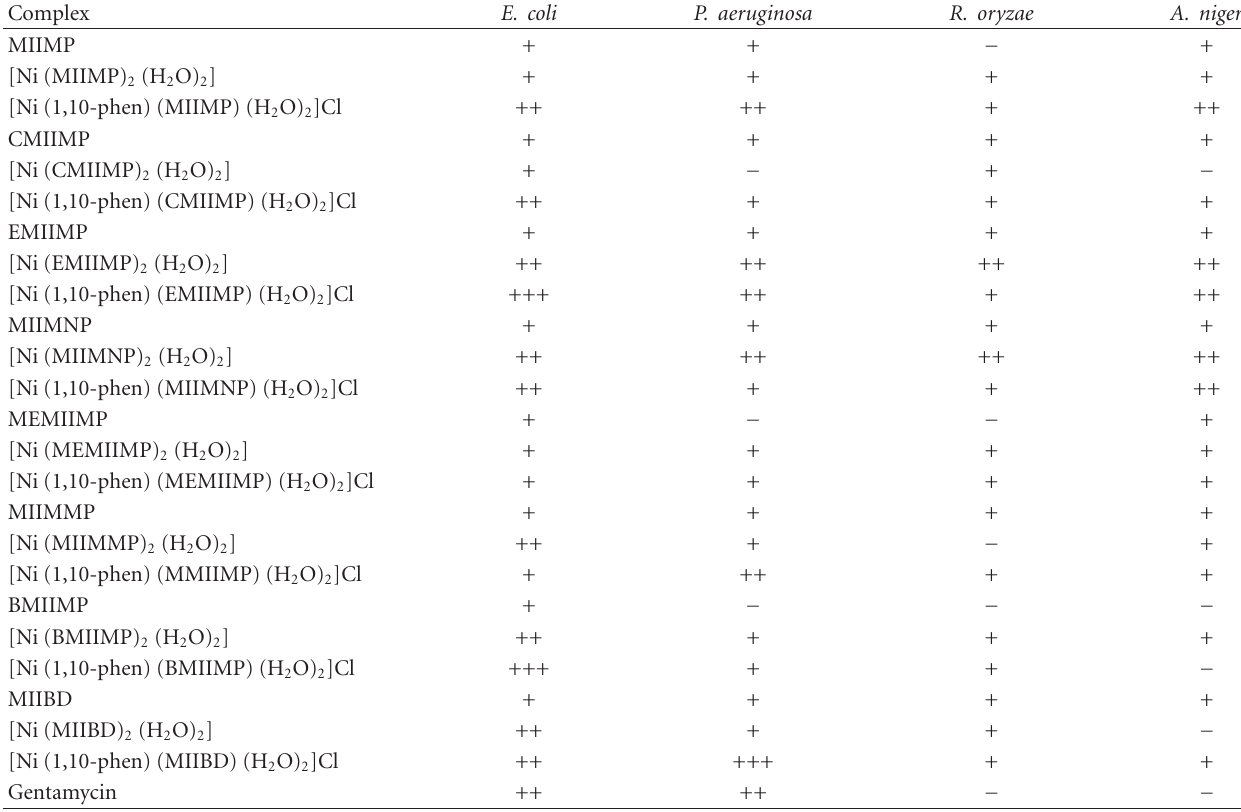
Figure 3: The optimized structural geometry of Ni(II) complexes. Table 4: Antimicrobial activity of ternary